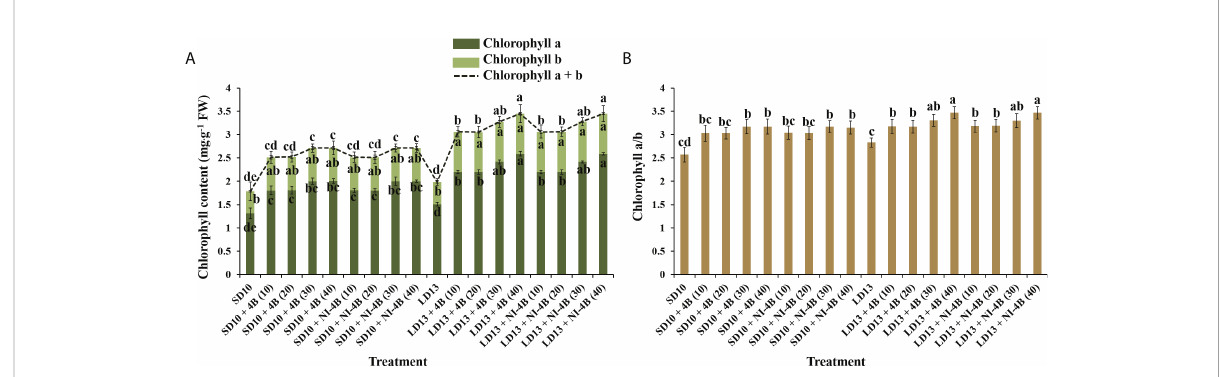
FIGURE 4 The effects on the chlorophyll content of chrysanthemum ‘ Gaya Glory ’ under different intensities of supplemental or night-interruptional blue light, after 60 days of exposure to the photoperiodic light treatments: the contents of chlorophyll a, b, and a + b (A) and chlorophyll a/b (B) . Vertical bars indicate the means ± standard error (n = 6). Different lowercase letters indicate signi fi cant separation within treatments by Duncan ’ s multiple range test at p ≤ 0.05. See Figure 1 for details of photoperiodic light treatments with blue